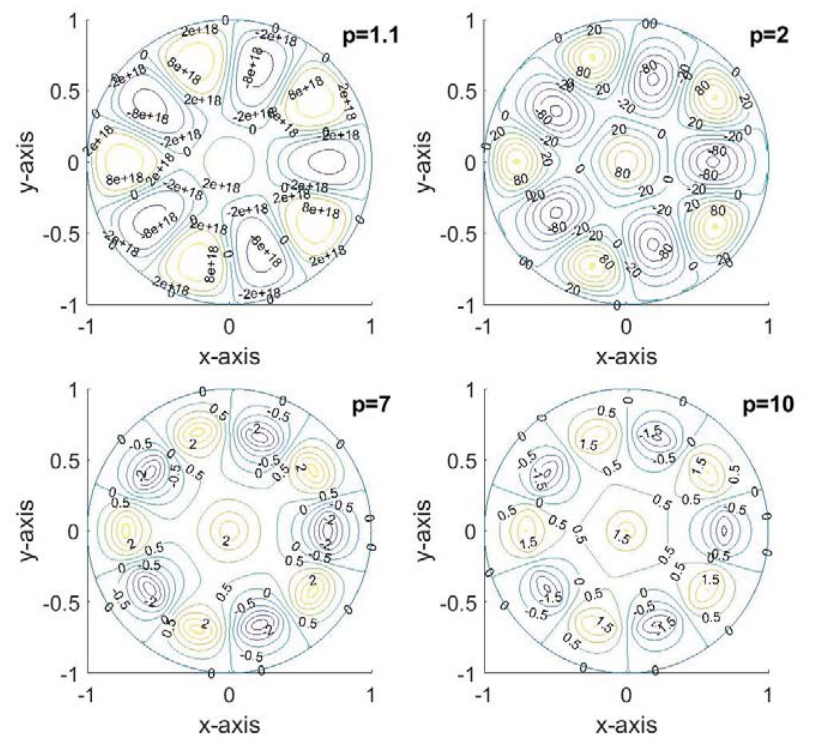
Fig. 17: Level sets of the numerical solutions with six nodal regions and